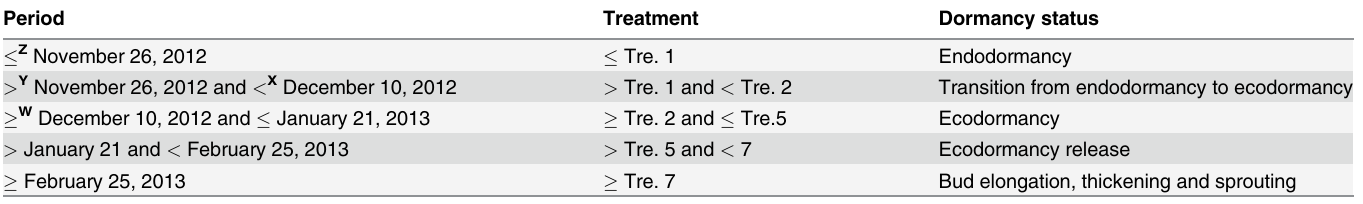
Table 9. Bud dormancy status of ‘ Hangbaishao ’ in different periods. Period